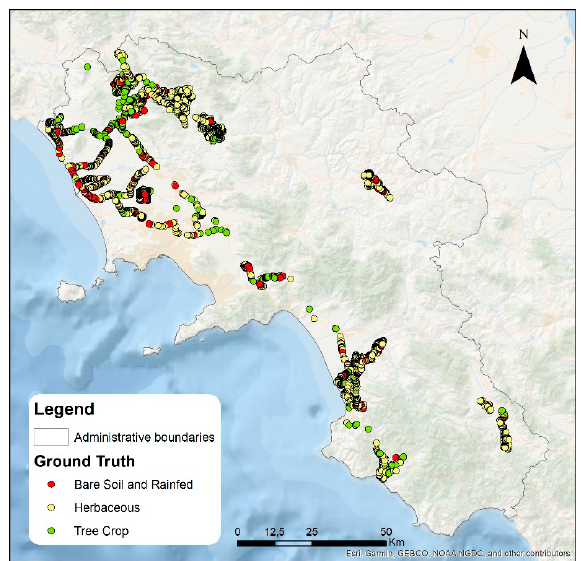
Figure 7. The 2992 ground truth samples collected over the study area across the three thematic classes: bare soil and rainfed (class 0), herbaceous (class 1), and tree crop (class 2). Table 4. Number of reference data acquired per tile and per class.